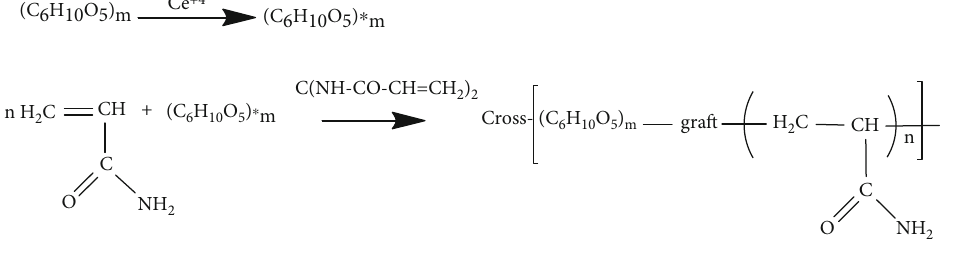
Figure 1: Schematic representation of hydrogel synthesis.